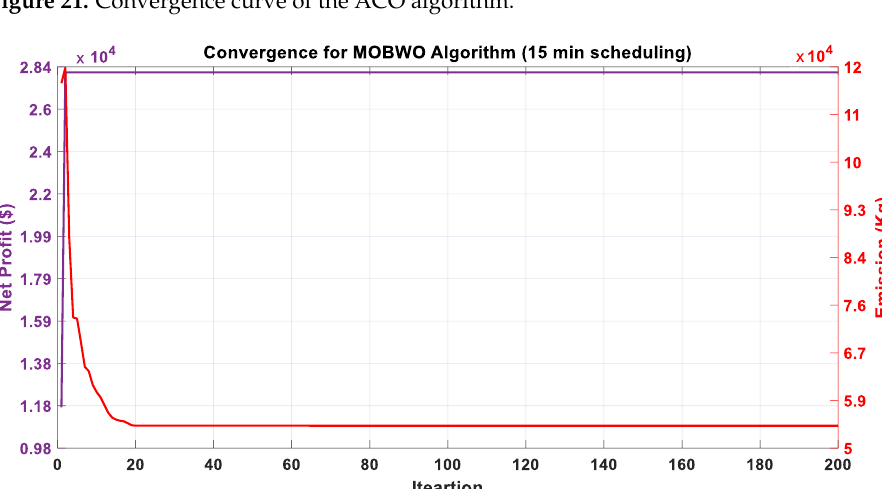
Figure 21. Convergence curve of the ACO algorithm.